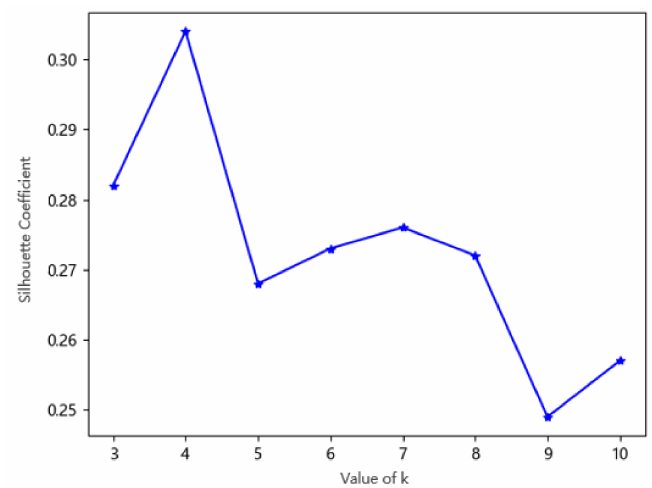
Figure 4. The Calinski–Harabasz (CH) score under di ff erent k